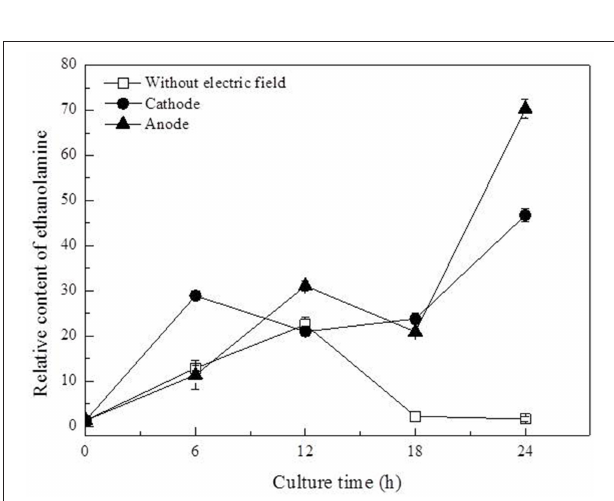
FIGURE 7 | Variation of ethanolamine contents in G. xylinus cultured with/without direct current electric